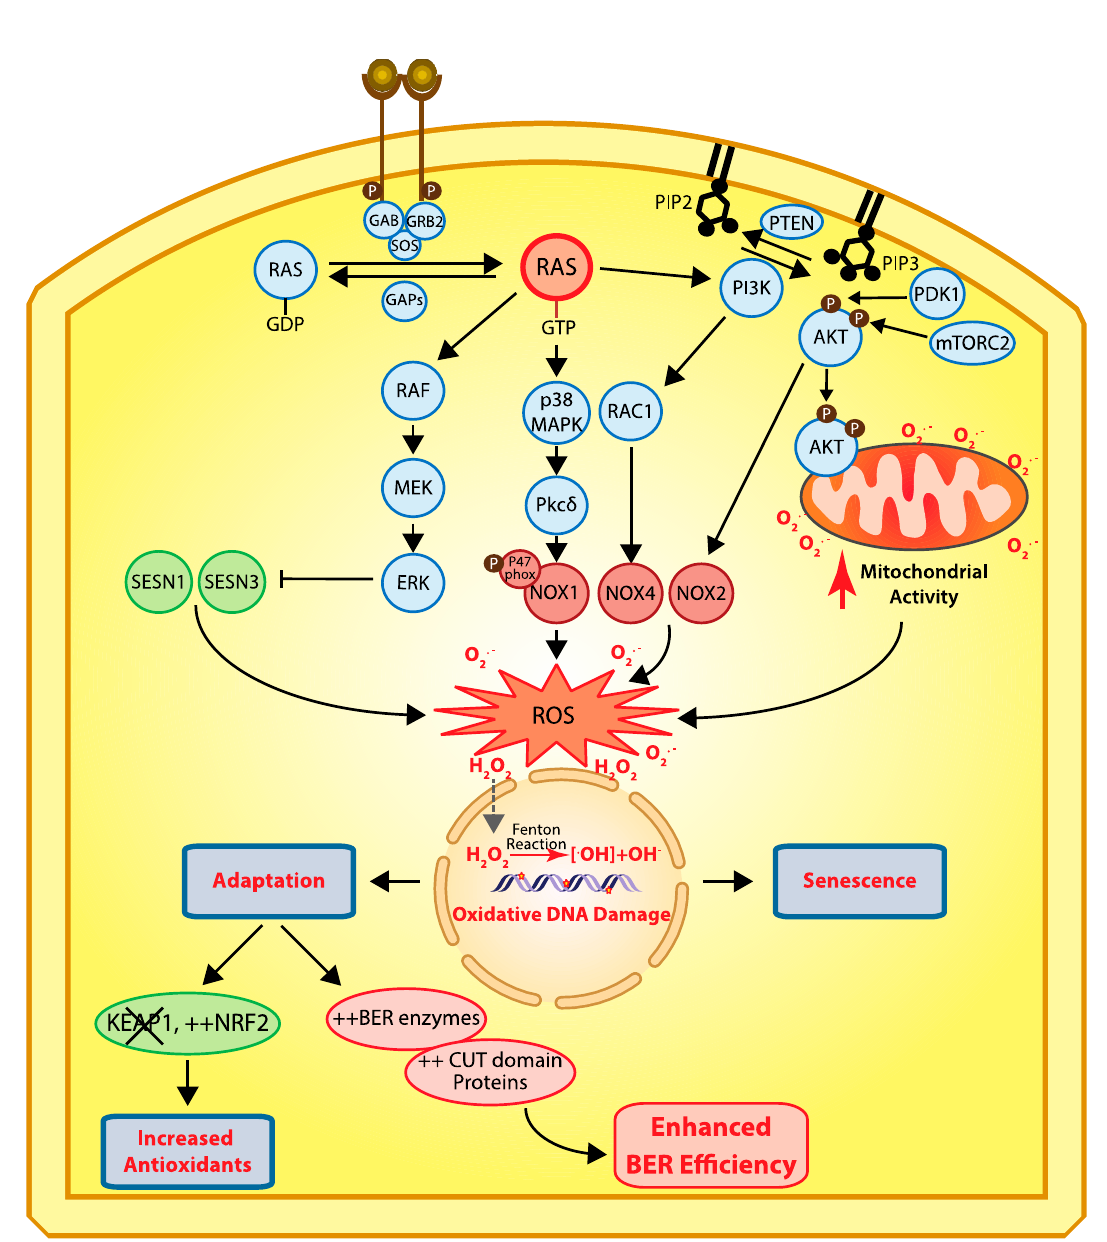
Figure 2. Cellular responses to RAS-driven production of reactive oxygen species. In physiological conditions, RAS proteins (KRAS, HRAS, and NRAS) alternate between their GDP- and GTP-bound states which are regulated by guanine nucleotide exchange factors (GEFs) and GTPase-activating proteins (GAPs) [40]. Binding of a receptor tyrosine kinase (RTK) to its ligand induces its dimerization and autophosphorylation, which in turn allows the recruitment of SH2 domain-containing proteins such as GRB2 that recruits the GEF protein SOS which then activates RAS [41,42]. In cancer, RAS is activated by a number of mechanisms including activating mutations in one of the RAS genes, overexpression of RTKs, and loss of GAP proteins (reviewed in [43]). In its GTP-bound state, RAS activates a number of downstream effector pathways that elevate the level of reactive oxygen species (ROS) in multiple ways [23]. The mitogen-activated protein kinase (MAPK) pathway leads to the transcriptional activation of NOX1 which codes for NADPH oxidase 1, a member of the NADPH oxidase enzyme family that catalyzes the one-electron transfer of oxygen to generate superoxide at the plasma membrane [21,44]. In addition, phosphorylation of the p47phox Nox1 subunit by protein kinase C δ (PKC δ ) induces its translocation to the plasma membrane [45]. Another study provided evidence that RAS-induced ROS production is dependent on RAC1 and NOX4, another member of the NADPH oxidase enzyme family [46]. The RAF–MEK–ERK pathway causes the transcriptional repression of sestrin family genes, SESN1 and SESN3, which code for antioxidant modulators of peroxiredoxins [47]. Another important signaling pathway downstream of RAS is the pleiotropic PI3K/AKT pathway [43]. Importantly, the PI3K/AKT pathway is frequently activated in human cancers in a RAS-independent manner following a mutation or amplification of PIK3CA which codes for the p110 α catalytic subunit of the phosphatidylinositol 3-kinase (PI3K) or following inactivation of PTEN, a gene encoding the tumor suppressor phosphatase and tensing homolog,